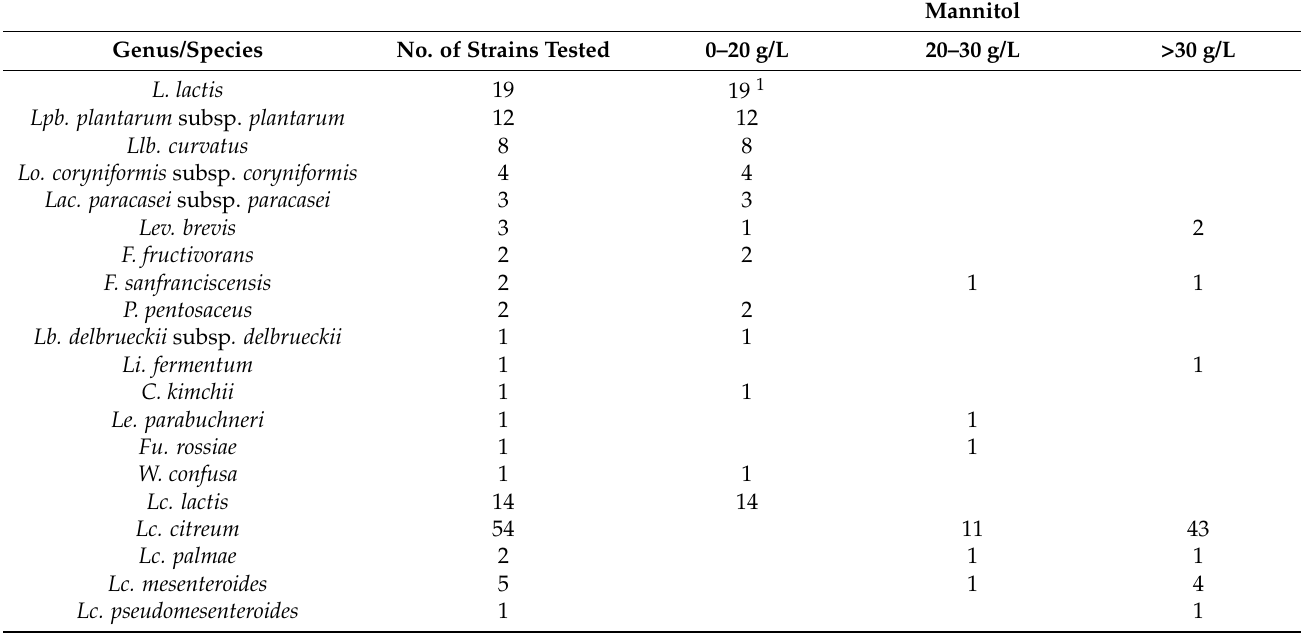
Table 6. Mannitol production of LAB in MRS medium supplemented with fructose (50 g/L) incubated at 30 ◦ C for 72 h. Mannitol Genus/Species No. of Strains Tested 0–20 g/L 20–30 g/L >30 g/L 19 19